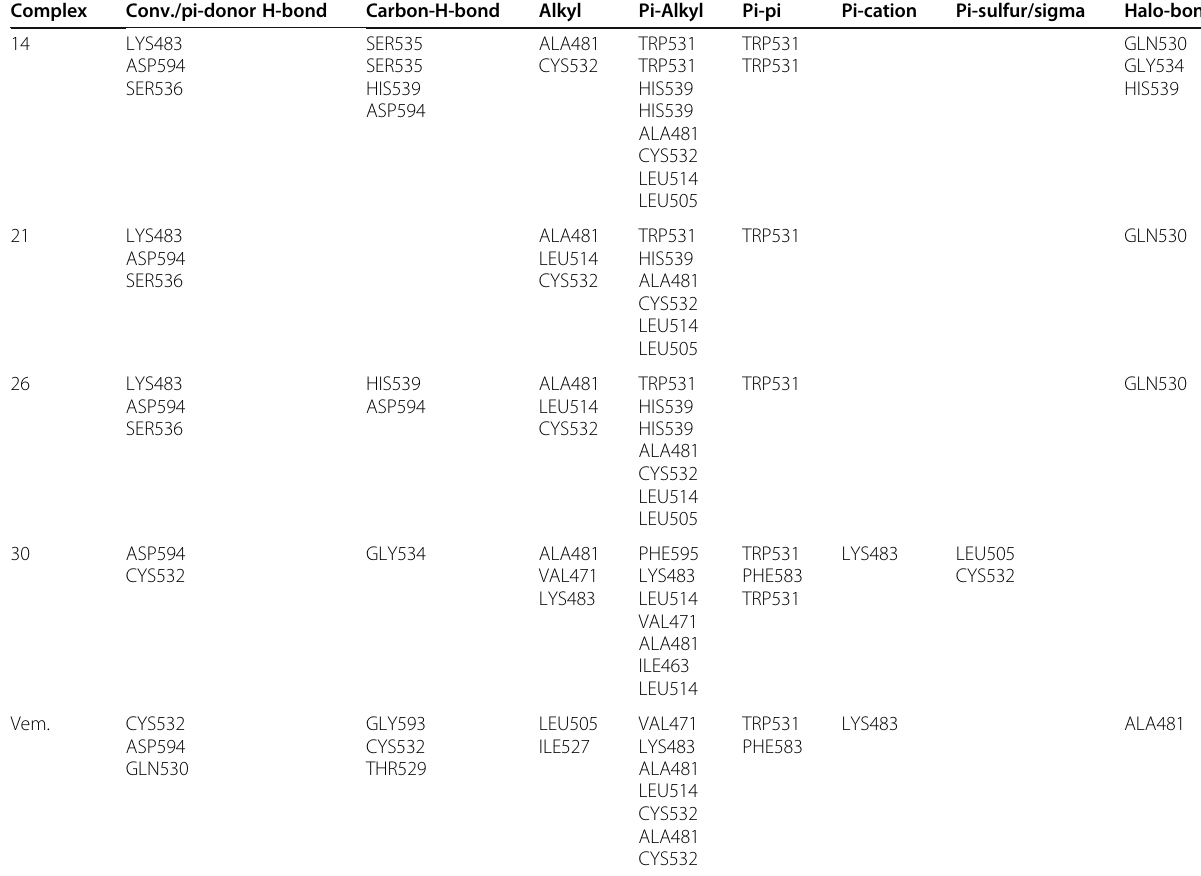
Table 3 Molecular interactions present in the selected complexes and the amino acids involved Complex